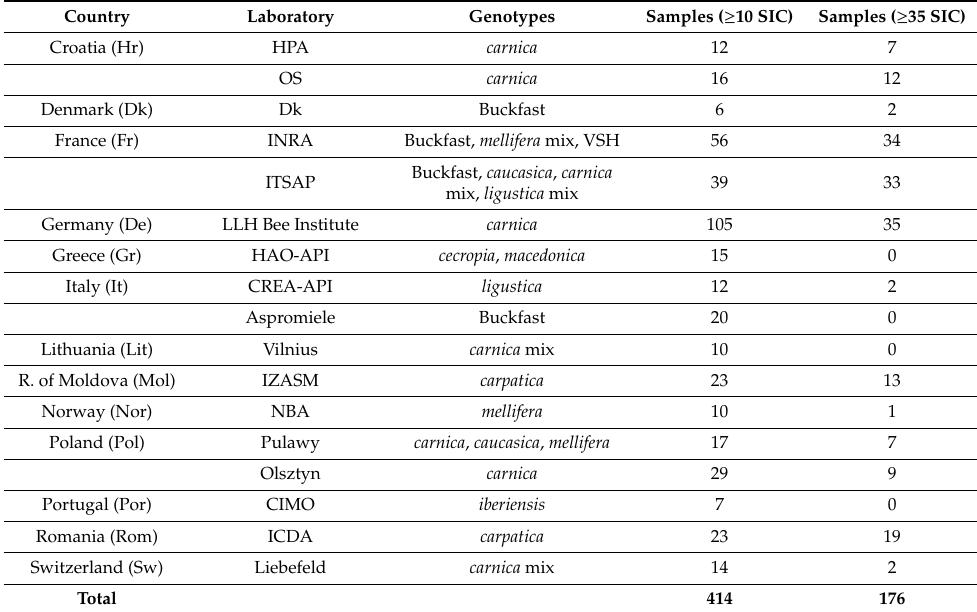
o ff spring. A table describing the normal development of mite o ff spring with regard to the development of bee pupae was used to determine whether the foundress mite would have produced at least one mated daughter by the time the bee emerged from the cell (Figure 1). Table 1. Sampling strategy throughout Europe and corresponding